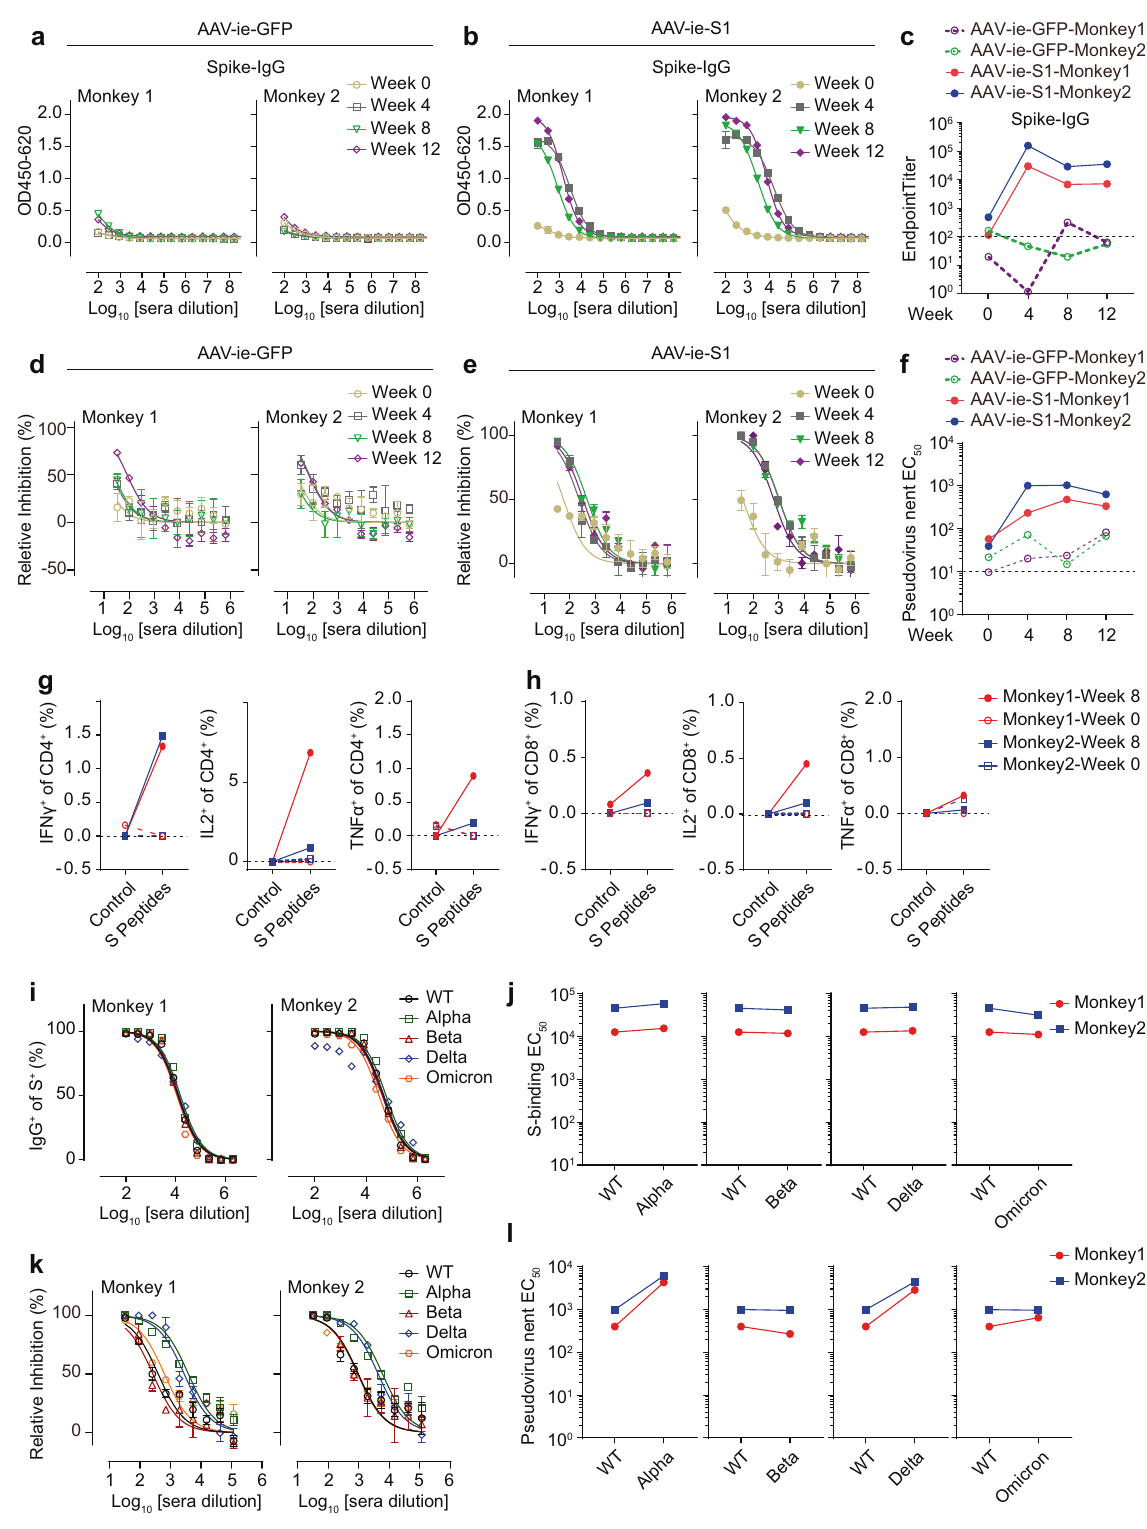
1040, and 638 on week 4, 8, and 12, respectively (Fig. 1d – f). These results showed that AAV-ie-S1 could induce robust humoral responses in non-human primates (NHPs). We then collected peripheral blood mononuclear cells (PBMCs) from monkeys